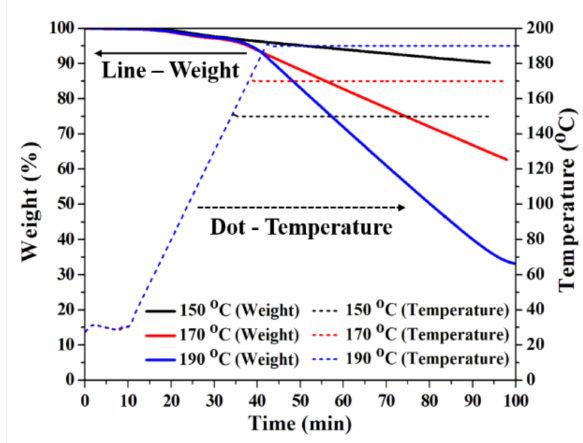
Figure 4. TGA analysis according to di ff erent heating times of the silver ink used to fabricate the electrode. (Straight line: weight %; Dotted line: heating temperature).